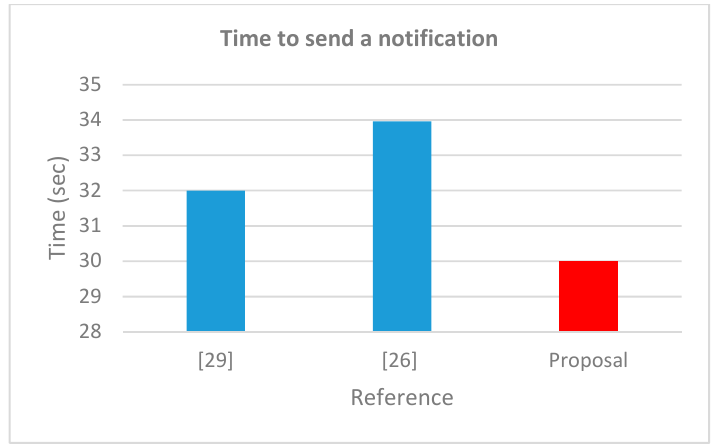
Figure 9. Comparison in notification time.